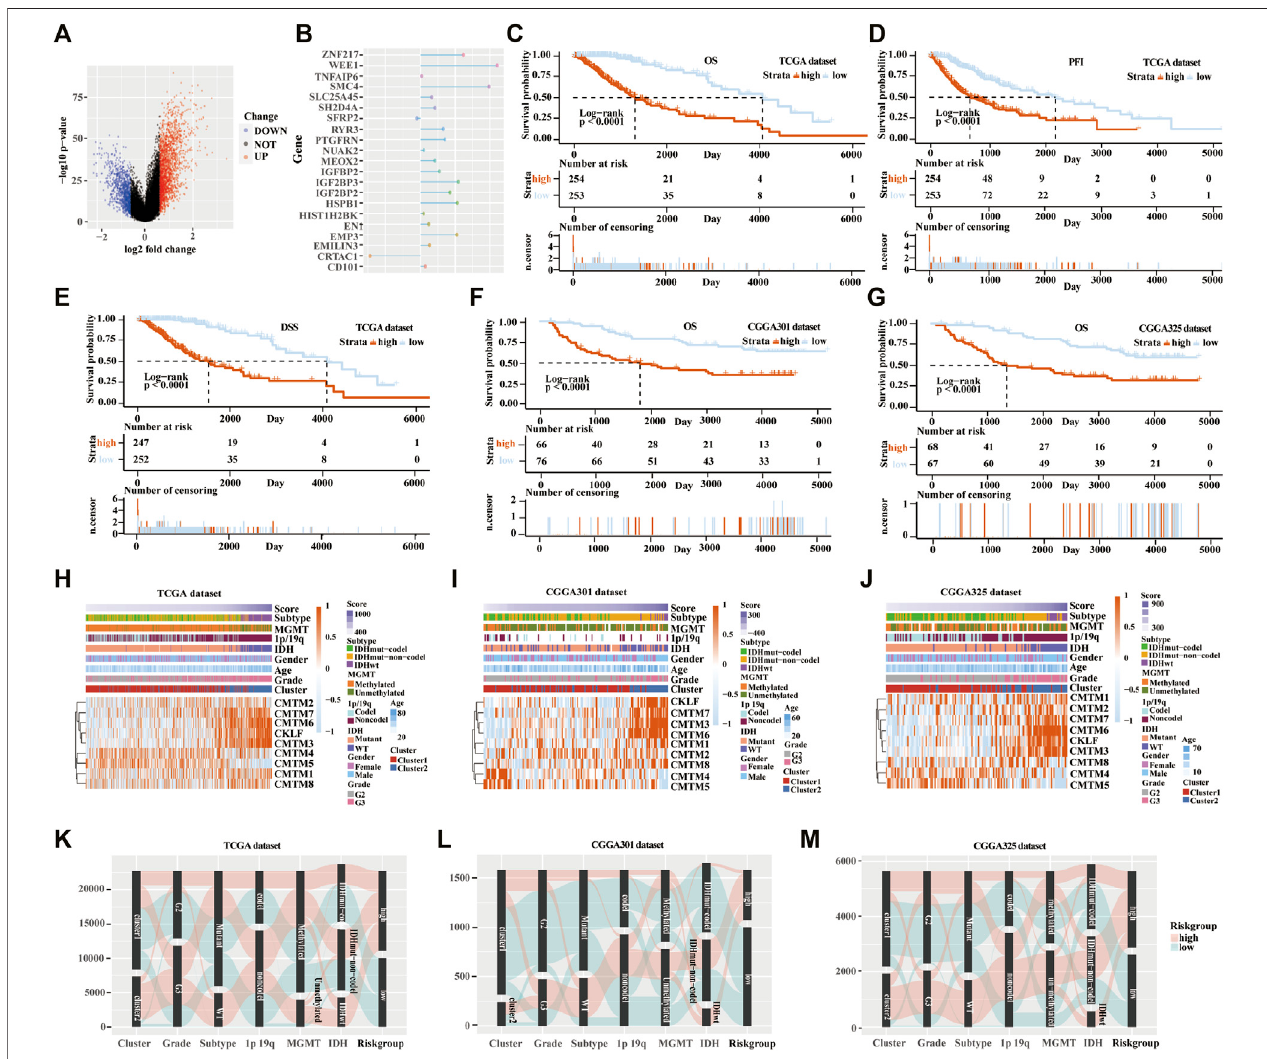
FIGURE 6 | Establishment and veri fi cation of the scoring model in the training and validation cohorts. (A) Volcano plot of differently expressed genes in the two clusters from TCGA database. (B) Elastic network map of 21 genes that were associated with prognosis in the two clusters from the TCGA database. Kaplan-Meier analysisofpatients in low-risk and high-riskgroups from theTCGA database forOS (C) , PFI (D) , and DSS (E) . (F) Kaplan-Meier analysisofpatients in low-risk andhigh- risk groups from the CGGA301 database for OS. (G) Kaplan-Meier analysis of patients in low-risk and high-risk groups from the CGGA325 database for OS. Heatmap of different glioma features and expression of CMTM in the low-risk and high-risk groups from the TCGA (H) , CGGA301 (I) , and CGGA325 (J) databases. Sankey diagram of different expression patterns of glioma features in cluster 1 and cluster 2 from TCGA (K) , CGGA301 (L) , and CGGA325 (M) databases, analyzed by the log-rank